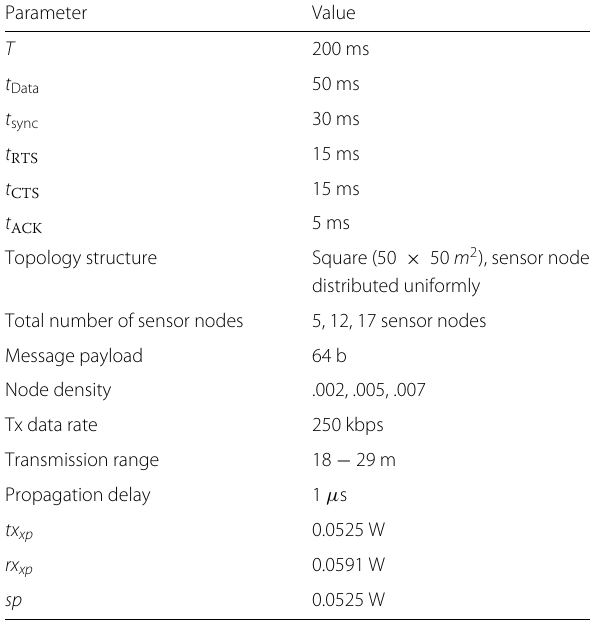
Table 2 Experiment parameters for X-MAC protocol Parameter